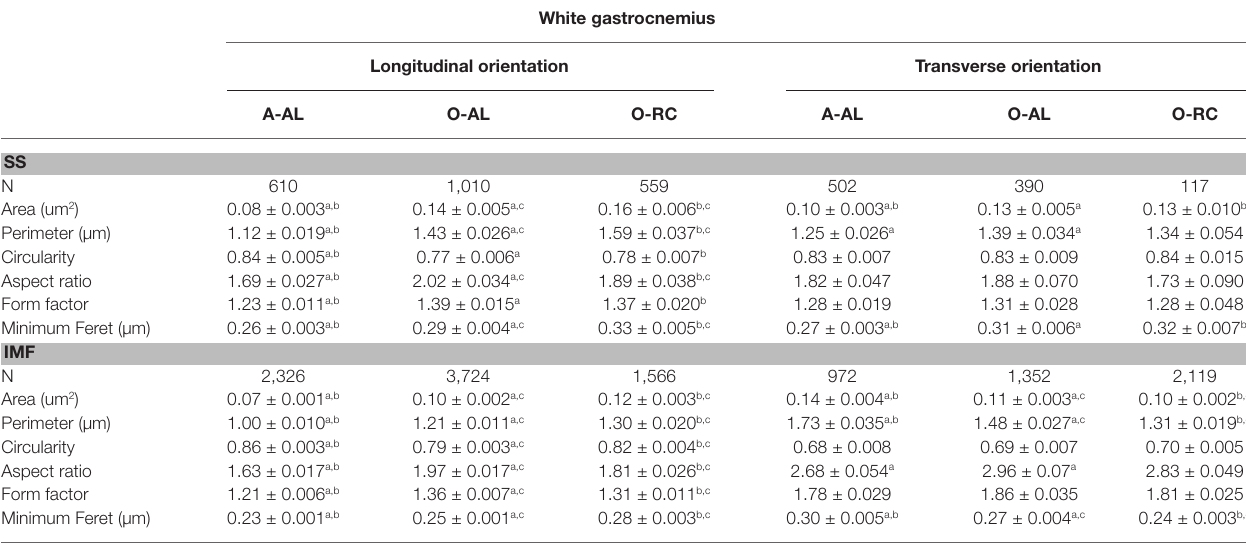
TABLE 2 | Effects of aging and caloric restriction on morphological parameters and shape descriptors of subsarcolemmal and intermyofibrillar mitochondria in the white